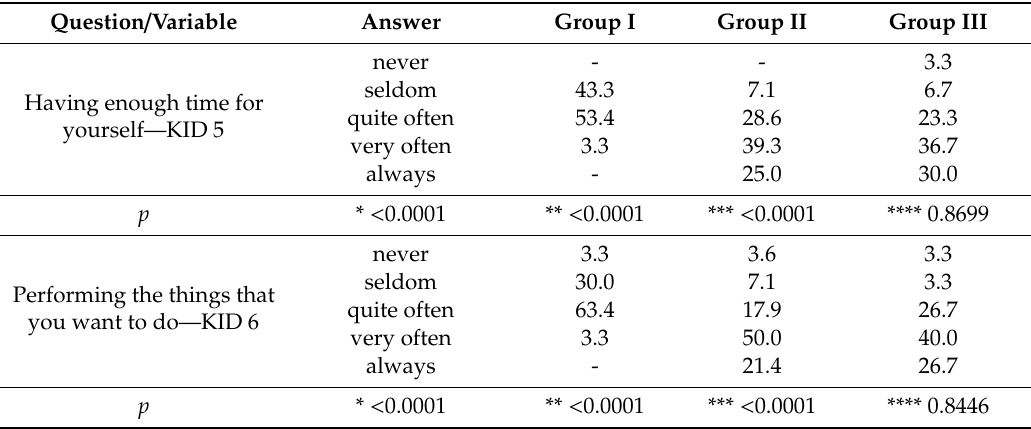
Table 7. The ability to set standards for yourself (the autonomy of the child). The percentage of respondents providing a given answer [%].